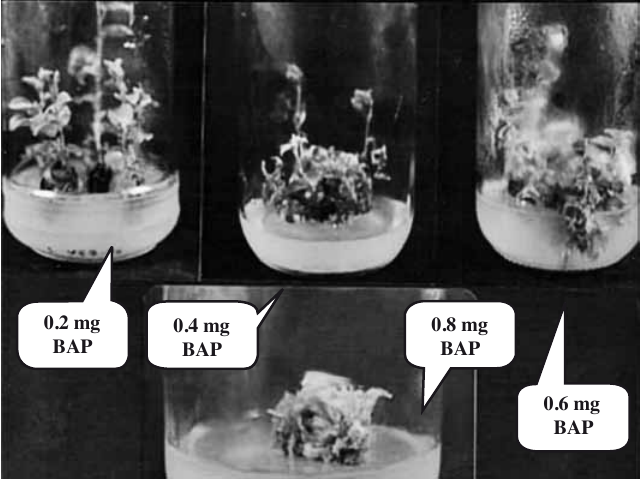
Fig. 1 - In vitro micro propagation of apricot cv. Canino on M derived from shoot tip